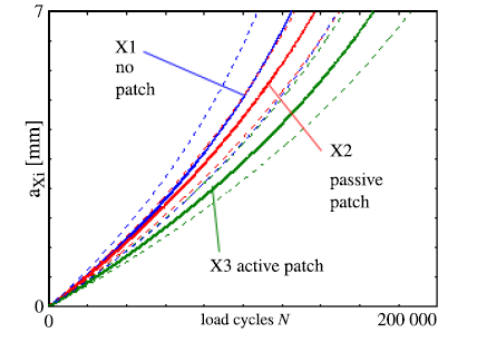
Figure 6. Summarized mean (——) and mean deviation (– – –) curves of crack length propagation a Xi versus load cycles N according to no applied patch for case X1 (top), applied passive patch for case X2 (middle) and applied active patch for case X3 (bottom).